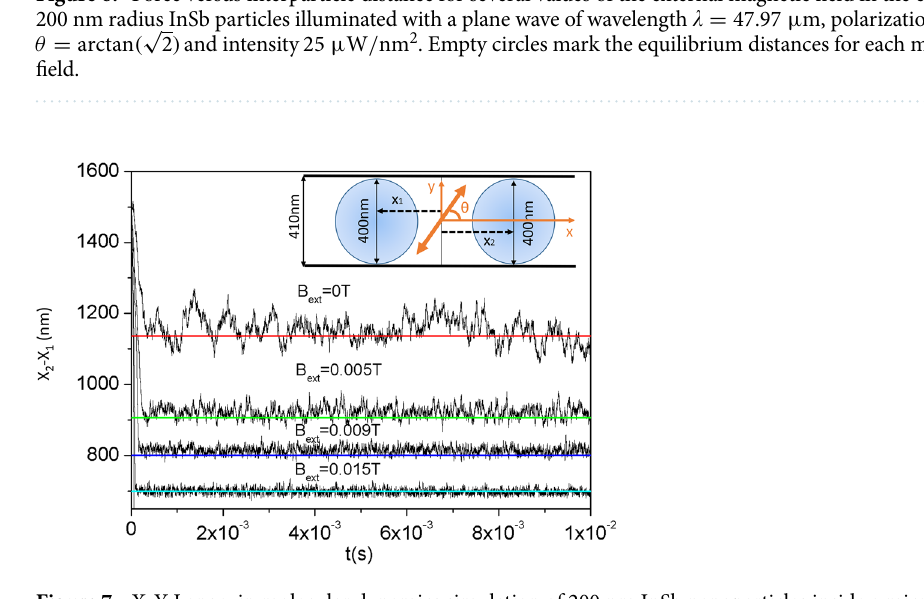
Figure 7. X-Y Langevin molecular dynamics simulation of 200 nm InSb nanoparticles inside a micro-channel with a diameter of 0.41 µ m illuminated by a plane wave with wavelength (cid:31) = 47.97 µ m, polarization angle arctan ( √ 2 ) and intensity 25 µ W / nm 2 . Temperature is set to 293K. The simulation shows the particles θ = separation versus time for different values of the external magnetic field. Straight lines correspond to the following expected equilibrium distances, d = 1136 nm (red), 906 nm (green) 800 nm (blue) 698 nm (cyan), obtained from the analytic expression Eq. (19). Inset shows a sketch of the particles configuration together with the polarization angle and the coordinate system